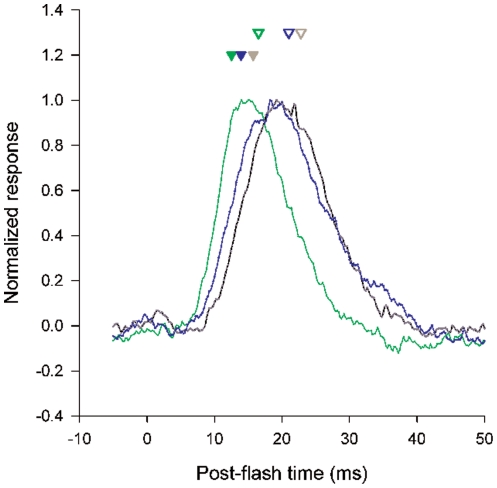
Impulse responses in green photoreceptors peak more rapidly and are completed earlier than those of blue or UV photoreceptors.Averaged impulse responses (300–500 sweeps per average) recorded from three photoreceptors from the same bee, normalized and superimposed for comparison. Actual response amplitudes were 1.2 mV, 1.2 mV and 1.3 mV for the green-, blue- and UV-sensitive photoreceptors, respectively. Impulse responses were recorded following 60 s adaptation to steady light at 470 nm (−0.75 log units intensity; green, blue photoreceptors) or 360 nm (−1.87 log units; UV photoreceptor). The mean depolarization of the resting membrane potential during light adaptation was 22.3 mV (green photoreceptors), 22.7 mV (blue) and 23.6 mV (UV). For comparison, mean values of the impulse response time-to-peak (t
p ) are indicated for green, blue and UV photoreceptors in Bombus terrestris
[10] (solid arrows, green, blue and grey, respectively), along with corresponding means for all photoreceptors in Bombus impatiens measured in this study (open arrows).